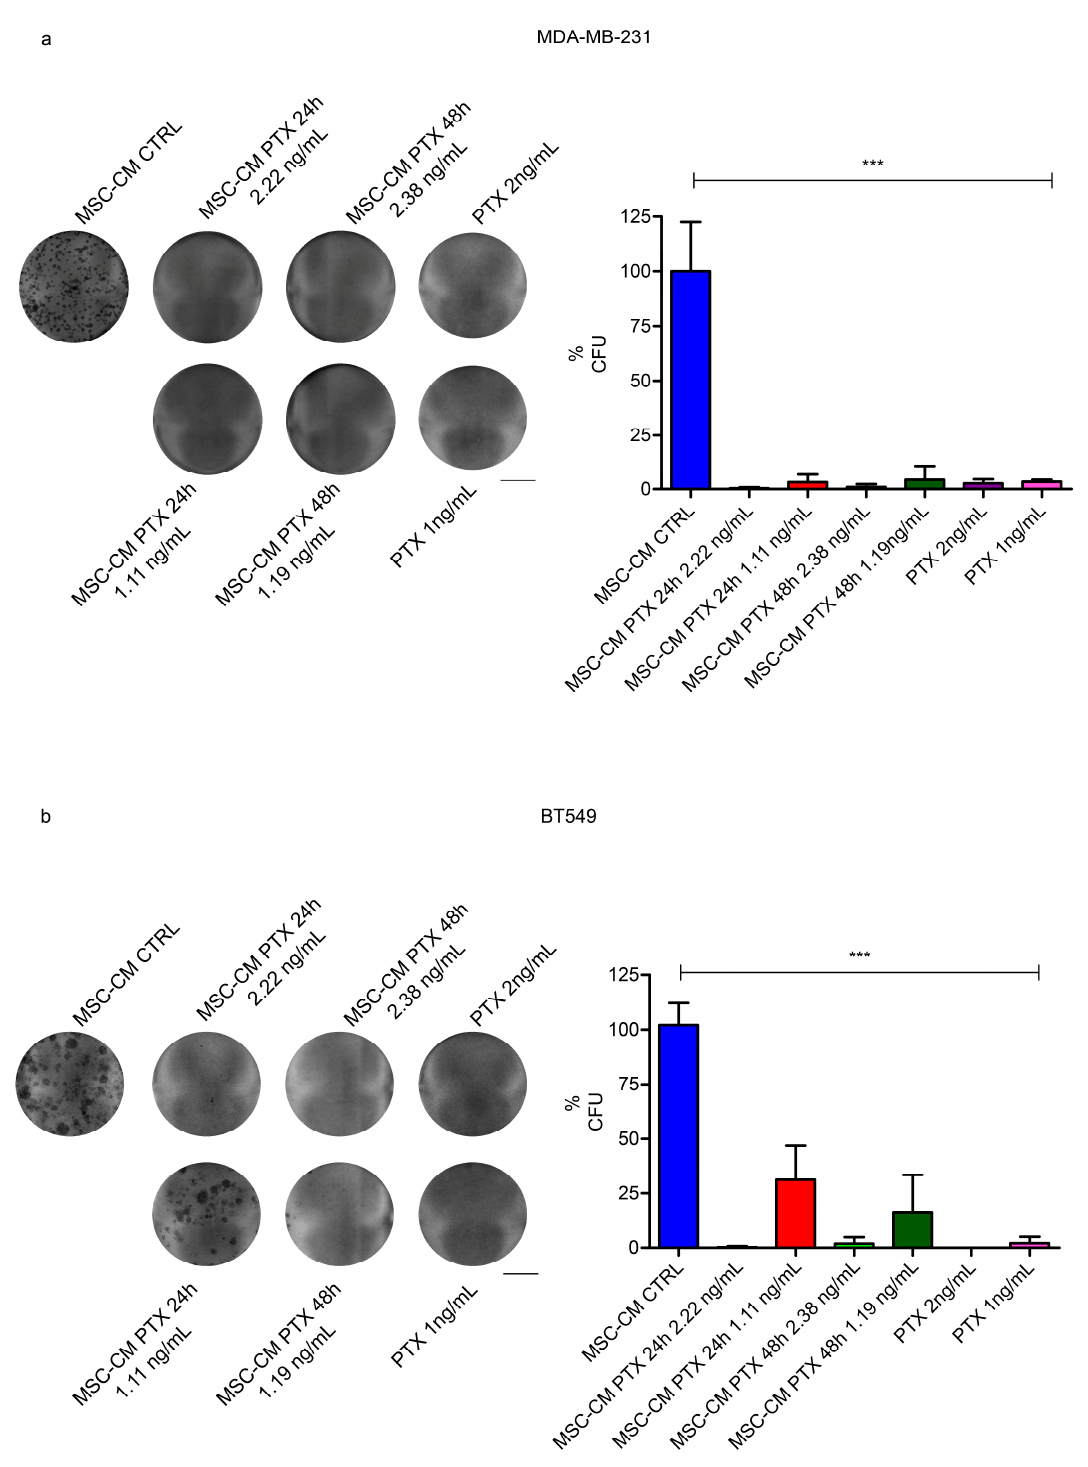
Figure 4. MSC-CM PTX 24 h/48 h effects on TNBC cell line colony formation. MDA-MB-231 and BT549 cells were seeded at very low densities, and single-cell colonies were counted after 14–21 days. Representative images of clonogenic assays (left) and histograms reporting the percentages of colony formation units (%CFUs) (right) of MDA-MB-231 ( a ) and BT549 ( b ) under different conditions are shown. Scale bar is equal to 10 mm. The experiment was performed in quadruplicate; unpaired t -tests determined p -values: *** p < 0.001; error bars indicate SDs. Scale bar: 10